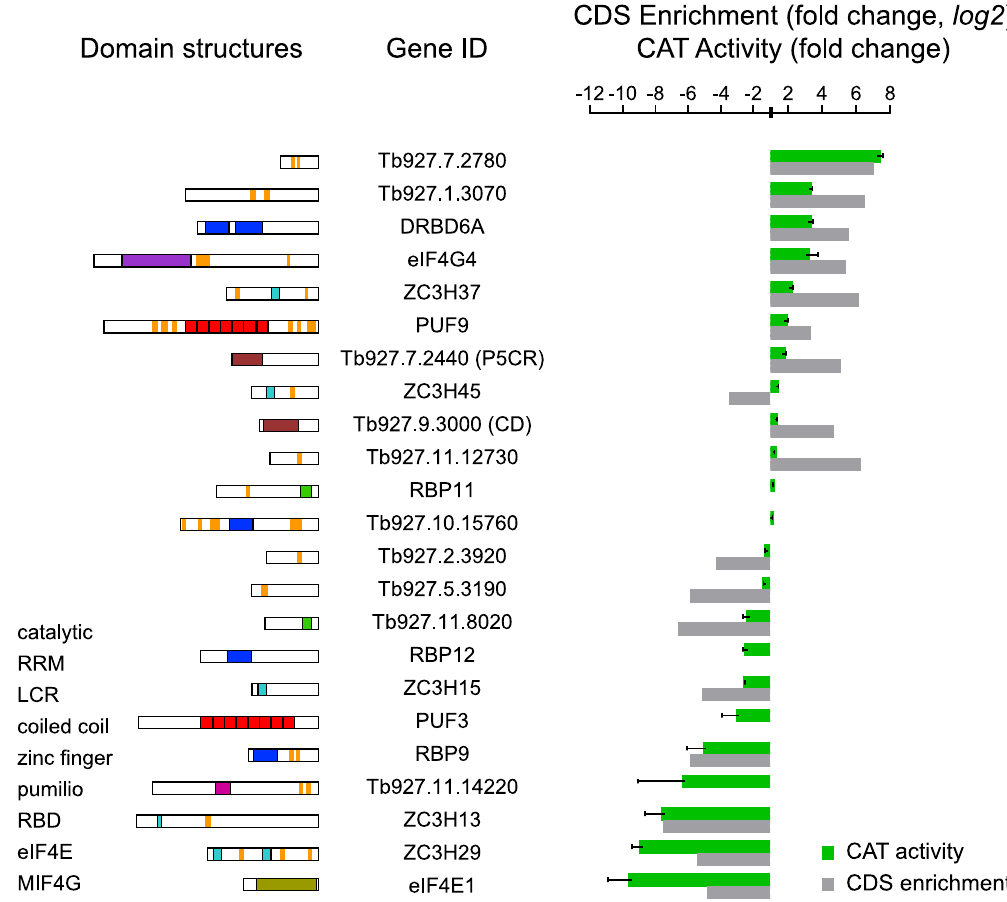
Figure 5. Validation of mRNA-fate regulators. Expression of CAT in cells expressing different myc-tagged lambda-N-fusion proteins was assayed after 24 h tetracycline induction and activities were expressed relative to a control with no lambda-N protein ( green ). Results are arithmetic mean 6 standard deviation of at least 3 independent clones. As comparison, the fold per CDS (log2 values) are shown ( grey ). ( left ) Domain structures of analysed T. brucei proteins as detected by SMART (http://smart.embl-heidelberg.de). Different domains are specific colours as shown on the blocks. P5CR, pyrroline-5-carboxylate reductase; CD, cytidine deaminase; LCR, low-complexity region; RRM, RNA recognition motif; RBD, RNA-binding domain. RBP11 and Tb927.10.15760 are negative controls, which did not have reproducible effects in the tethering